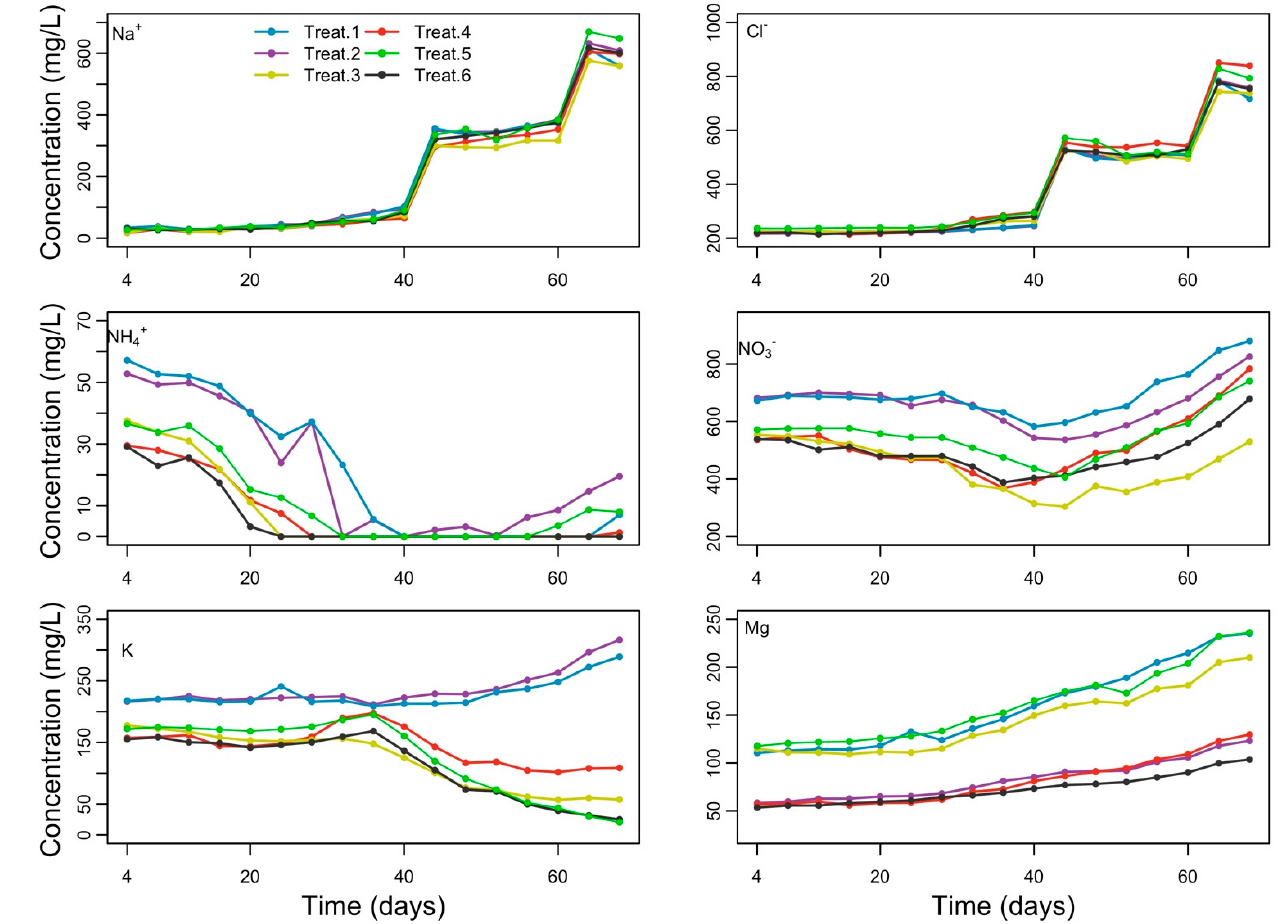
Figure 2. Salt and nutrient accumulation over time in closed hydroponic system.